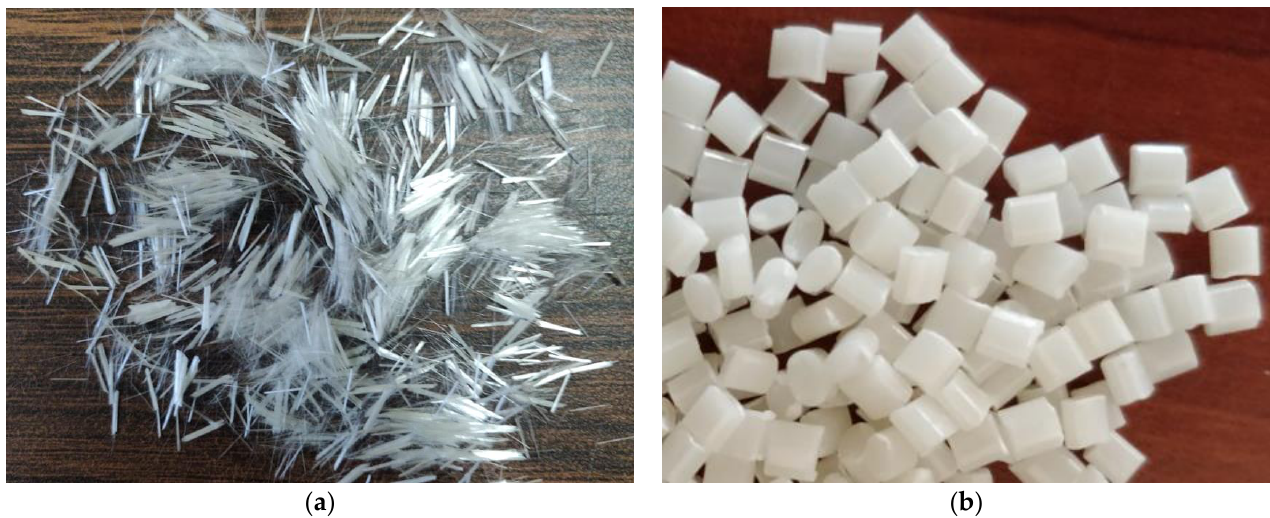
Figure 3. SEM and EDAX of as received short glass fibre. Removal of moisture plays a prominent role in improvisation of functionality and smoothing the flow process. ABS pellets were dried for a period of 2 h at a temperature of 120 °C. Once the process of drying was completed, these dried pellets were subjected to the compounding process. Short glass fibres were measured in definite quantities and added to these dried pellets before being fed into the compounding machine. Com- pounded pellets were subjected to a twin screw extrusion process. For the extrusion of 1.75 mm diameter filament, a single screw double rod extruder was utilised, and a lab grade compounding machine was employed. A prep-mixer was used to combine ABS pellets and glass fibre at a rotor speed of 50 rpm at a temperature of 225 °C. Mixtures of 15 and 30 wt% SGF were prepared. Under similar circumstances as the control parame- ters, a neat ABS has also been developed through the mixer. These mixtures were ex- truded using a twin screw extrusion unit at 220 °C as preforms. For FDM printing fila- ment, a 1.75 mm diameter cylindrical die was employed. During the process, the barrel temperature ranges between 200 and 230 °C. Figure 4 shows the short length of filaments developed with the assistance of the twin screw extrusion process, which was utilised for the development of the specimen.